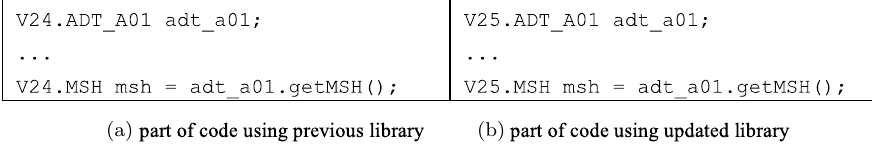
Fig. 3. Examples of code based on di®erent versions of library.